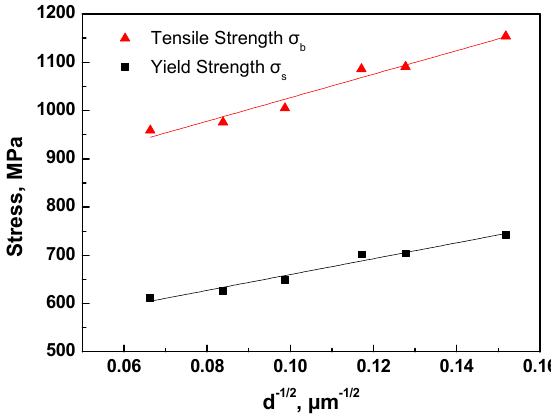
Figure 11. Relationship between the measured austenite grains and strength.